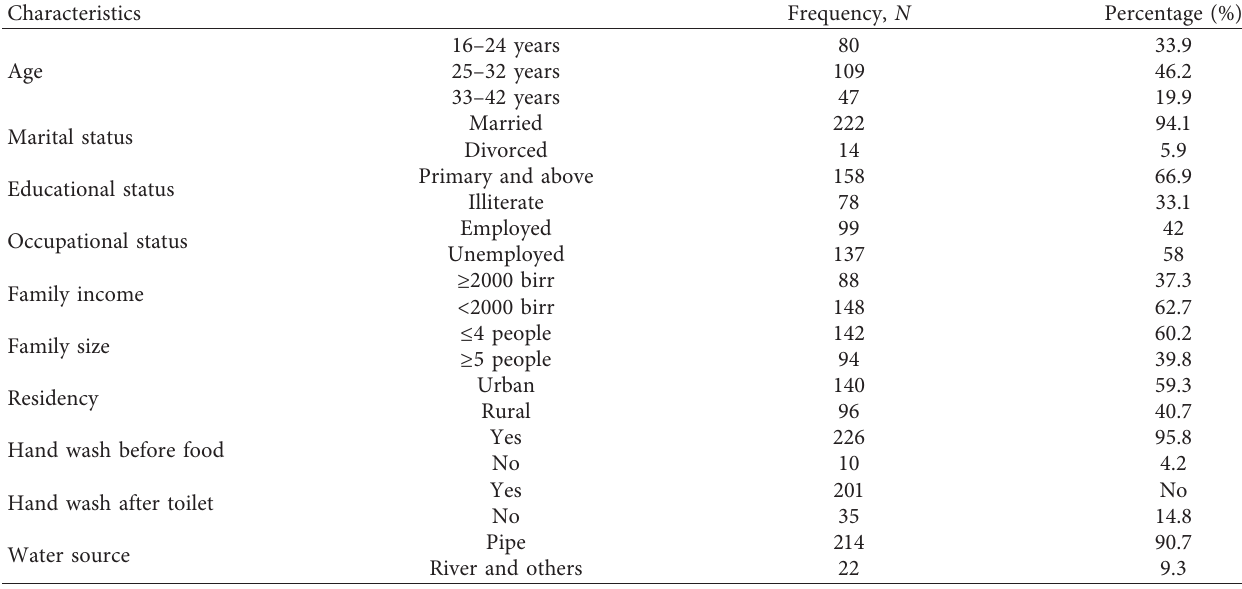
Table 1: Sociodemographic characteristics of the study participants in Kulito Health Center, SNNPR, Ethiopia, 2018 ( n � 236). Characteristics